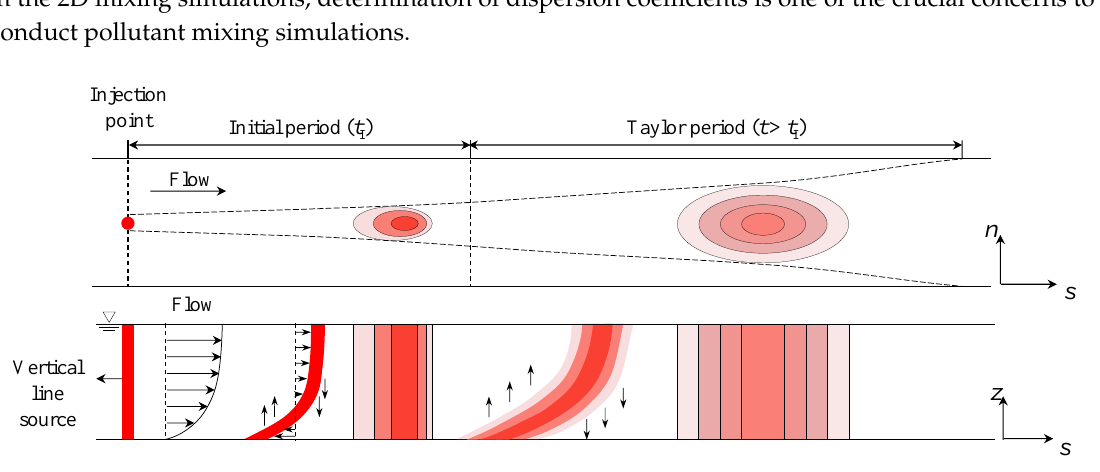
Figure 1. Descriptions of solute mixing by shear flow in initial and Taylor periods.